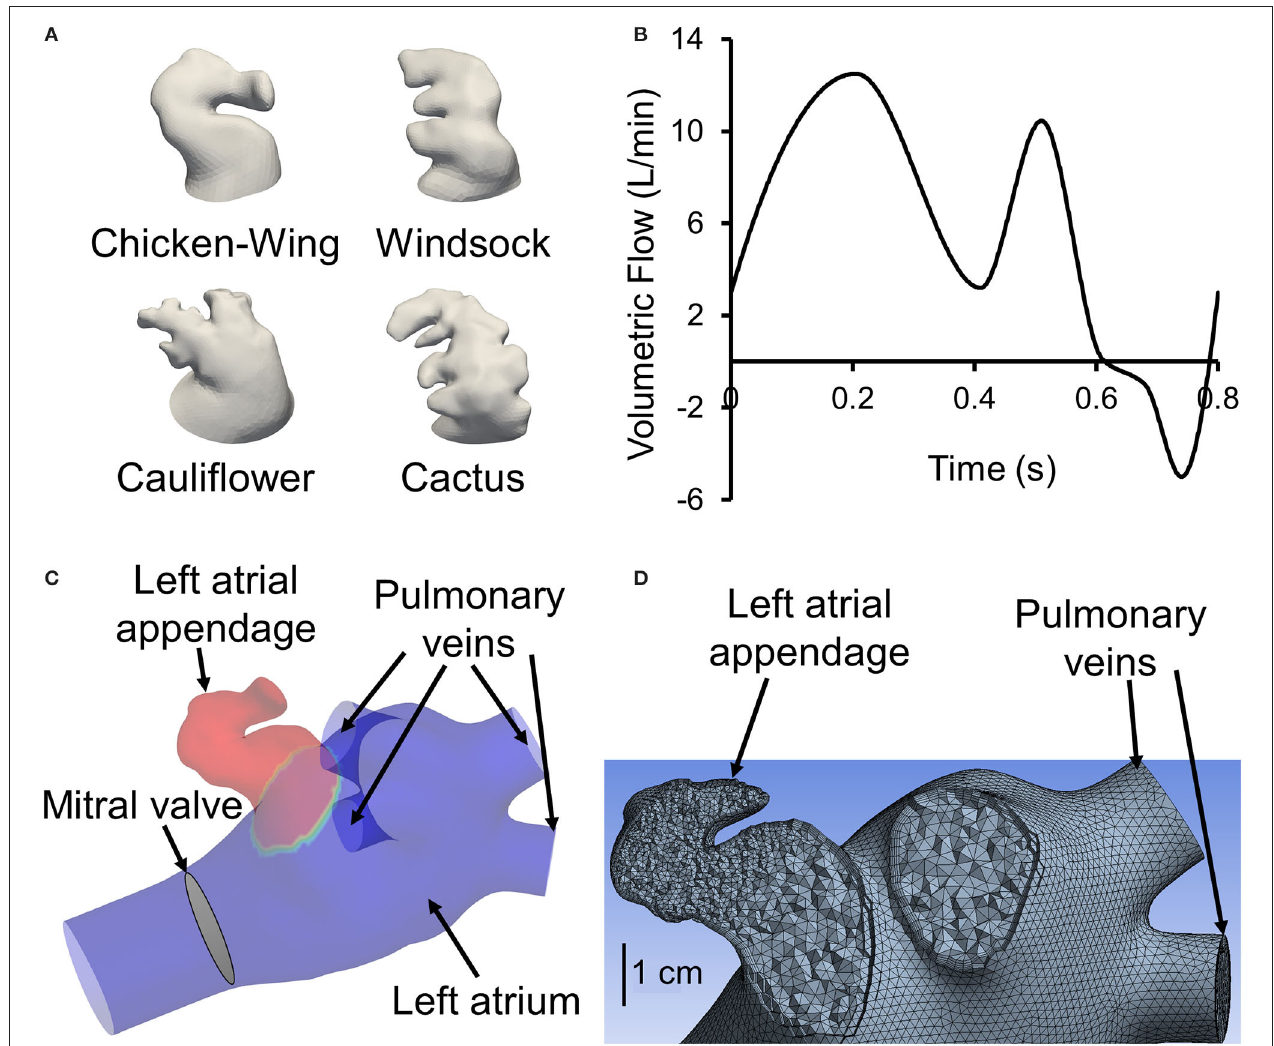
FIGURE 1 | (A) One representative 3D reconstructed left atrial appendage (LAA) surface geometry from our cohort from each of the four categories proposed by Di Biase et al. (2012). (B) Generic flow waveform over one cardiac cycle used to generate subject-specific waveforms based on subject’s cardiac output and heart rate (adapted from Smiseth et al., 1999). To avoid tracers exiting left atrial inlets, the waveform is shifted such that the backflow occurs at the end of the cardiac cycle around t = 0.6s. (C) Sample geometry with LAA filled with tracer (colored red). All inlets (four pulmonary veins), the outlet (mitral valve), and the location of LAA are displayed. (D) A representative left atrium and LAA geometry meshed with tetrahedrons. A section through the appendage region shows a finer mesh inside the appendage. Furthermore, it shows the use of prismatic layers at the wall